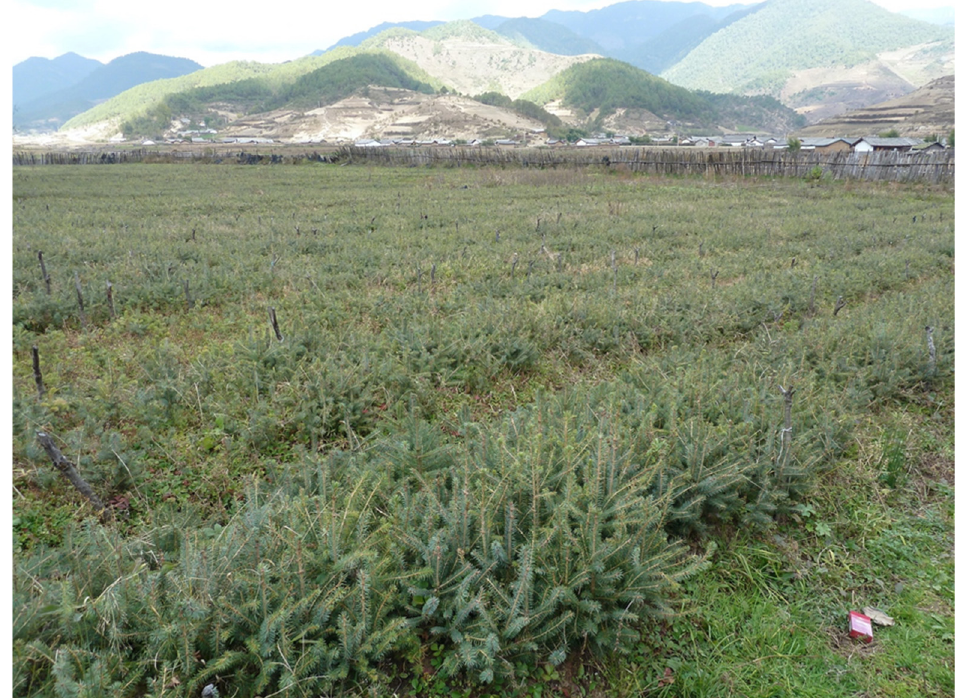
Figure 7. The cash cropping of Yunnan pine trees in Niplat which, when more mature, would be transplanted to deforested mountains such as those in the background, 2011. Photograph by the author.